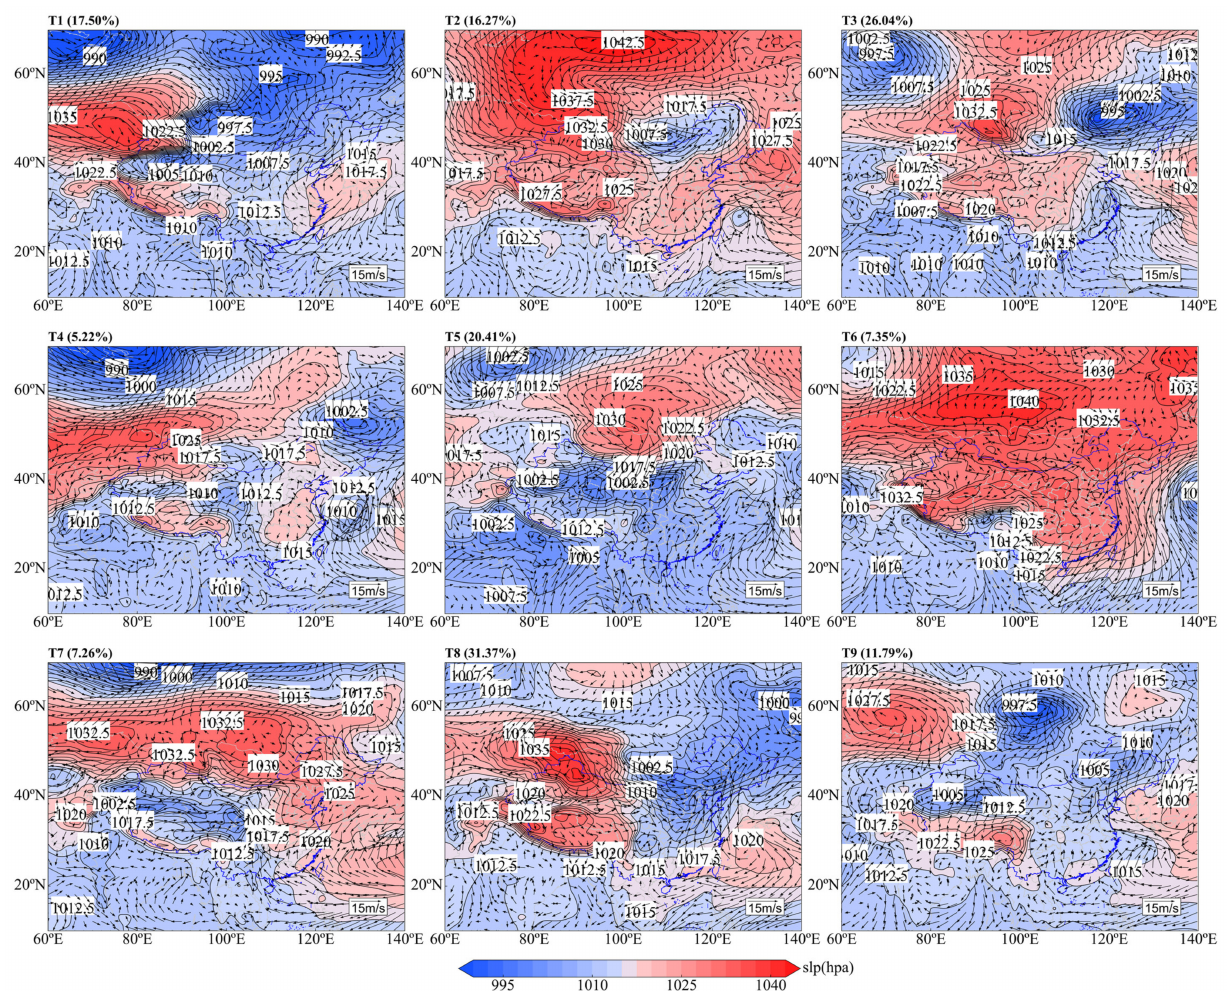
Figure 6. Distribution of the SLP field and the 10 m wind field of the nine circulation types in spring from 2000 to